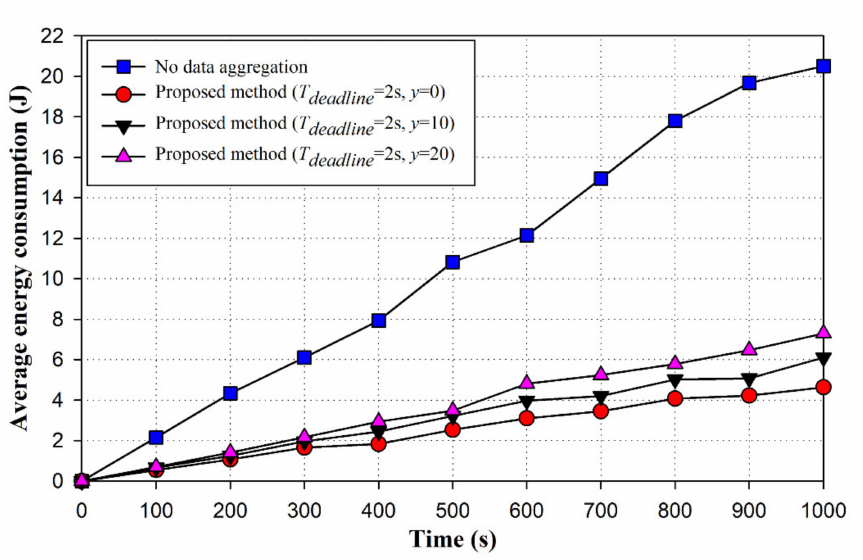
Figure 7. Average energy consumption with the deadline of 2